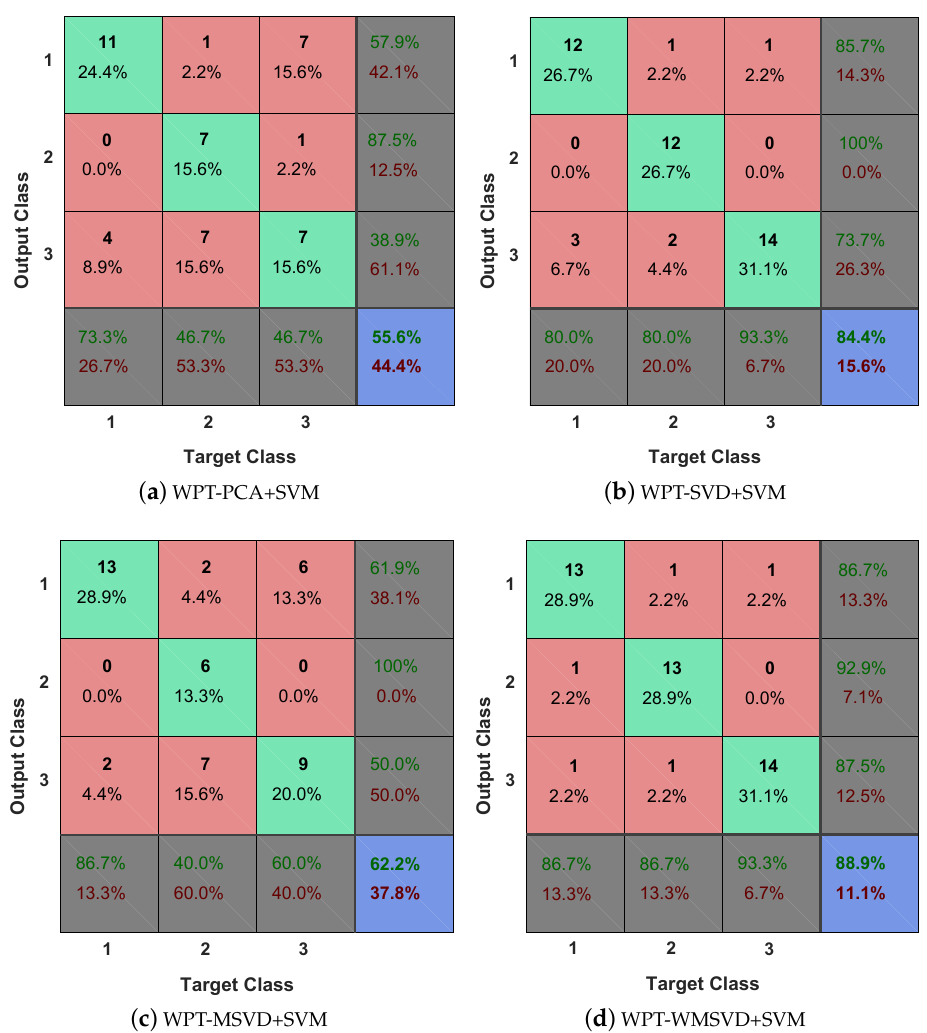
Figure 8. Classification confusion matrix of four algorithms: ( a ) WPT-PCA+SVM; ( b ) WPT-SVD+SVM; ( c ) WPT-MSVD+SVM; and, ( d ) WPT-WMSVD+SVM.